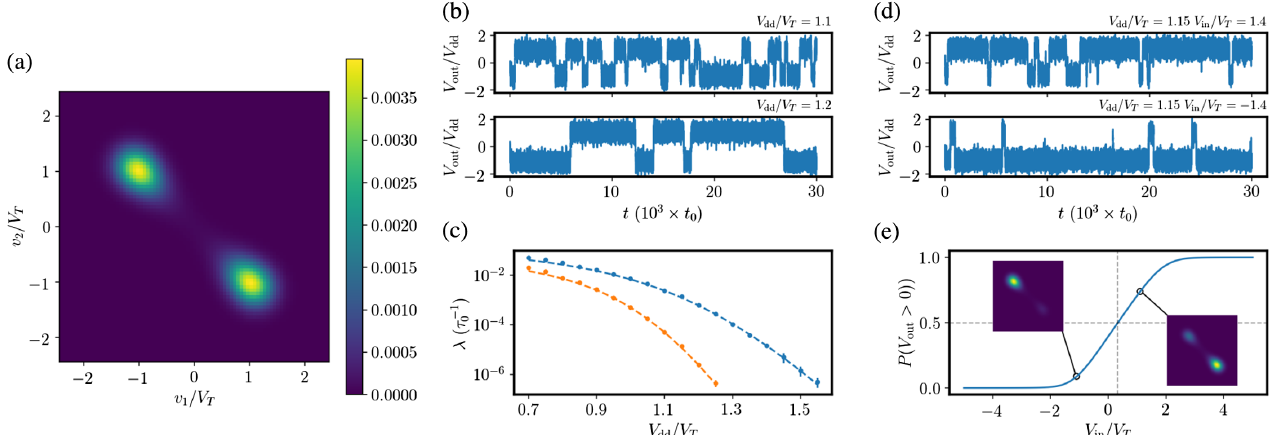
FIG. 14. (a) 2D histogram of the steady state distribution. (b) Output voltage as a function of time for two different power voltages. (c) Transition rate λ as a function of the power voltage. Dashed lines correspond to the spectral method developed in Ref. [90], and dots to the calculation of λ from stochastic trajectories like the ones in (b). In the last case, the error bars indicate the uncertainty in the determination of λ (95% confidence interval) and can be reduced by generating longer trajectories. The orange line and dots correspond → 2 C to doubling the scale of the device ( C ). (d) Output voltage as a function of time for two different input voltages V o;g o;g (e) Probability of the output being positive as a function of the input voltage. The insets show the steady state distribution for 1 . 1 . In all cases, the parameters are V 26 mV, C 50 aF, C 10 − 2 C V =V , and n ¼ 1 T ¼ (cid:2) T ¼ g ¼ o ¼ g in